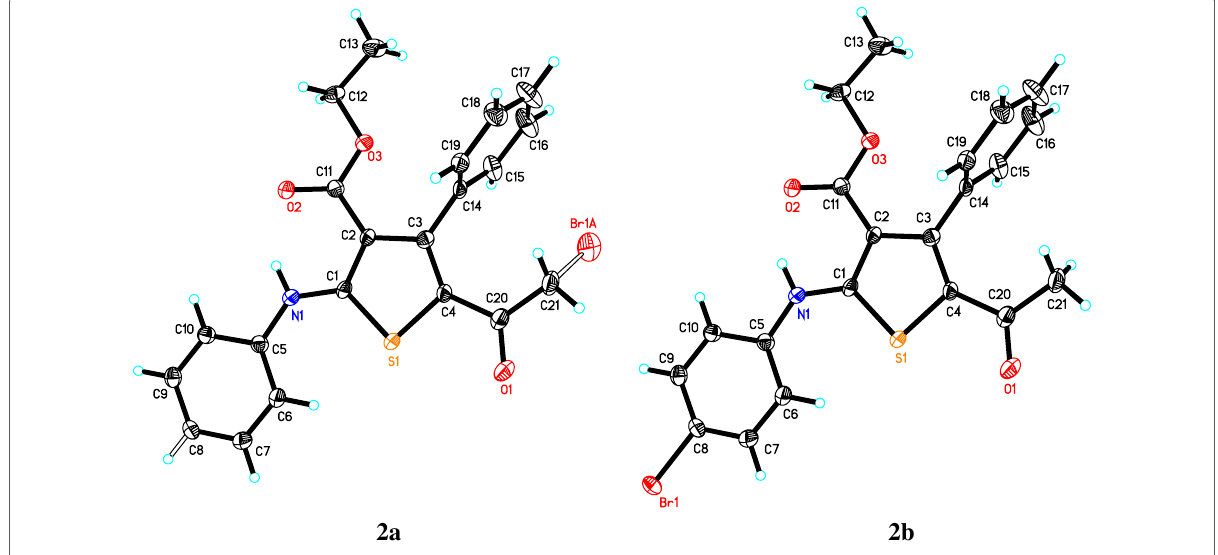
Fig. 3 ORTEP diagram of the titled compound showing the two isomers, 2a and 2b , separately for